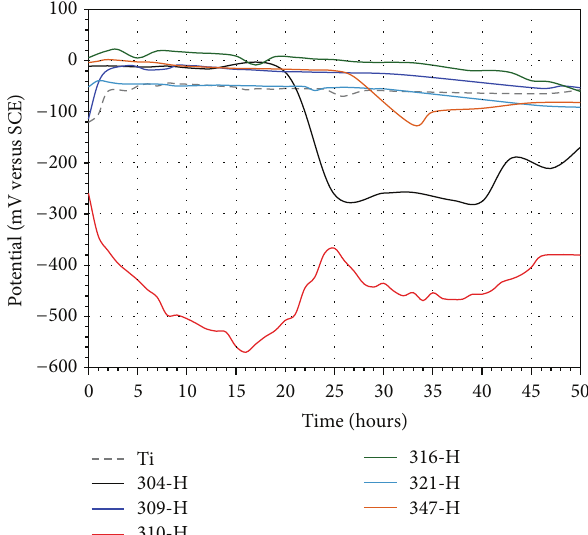
Figure 8: 𝐸 values after testing time for materials in artificial corr saliva at 37 ∘ C.